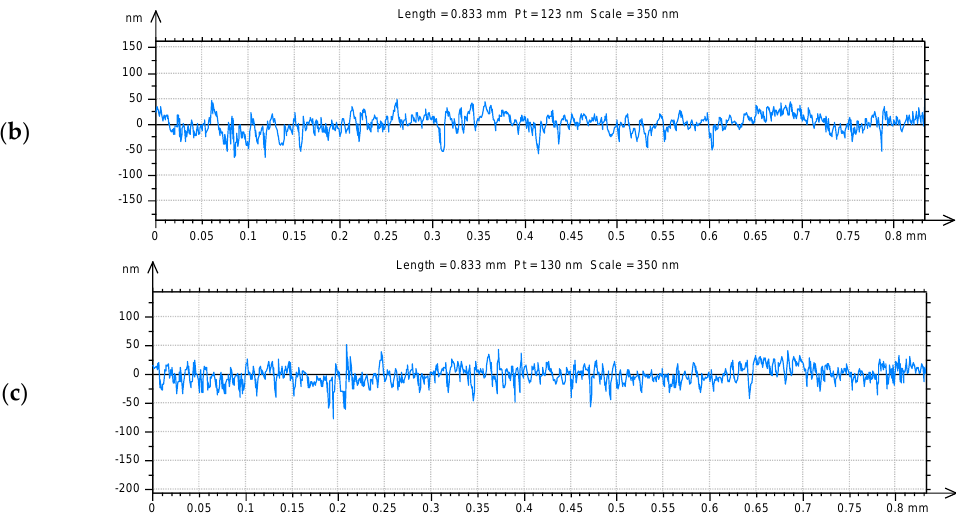
Figure 4. Profiles of surfaces: base no. 1 [20] ( a ), modified no. 2 ( b ) and modified no. 3 ( c ). To describe the surfaces’ geometry, some surface topography parameters from height, spatial and functional groups were selected. Topography parameters were calculated according to the ISO 25178 standard and with special application usage.